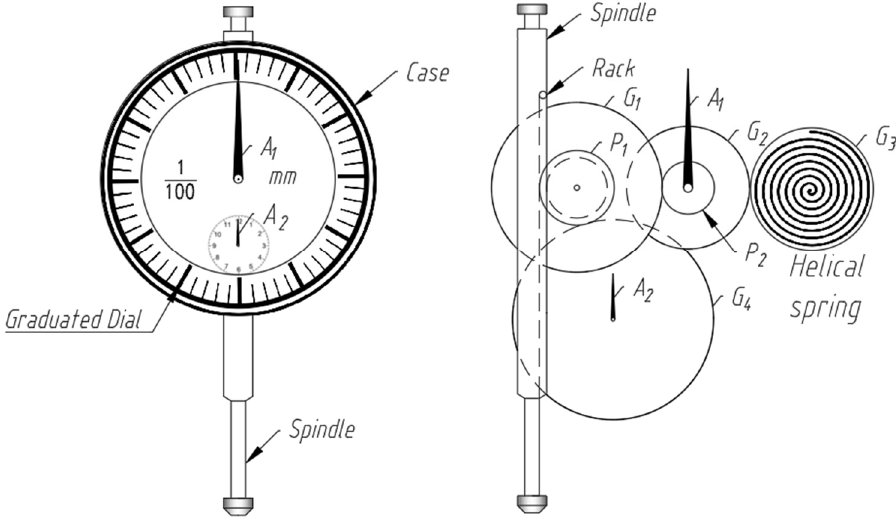
Figure 10. Dial gauge [77].